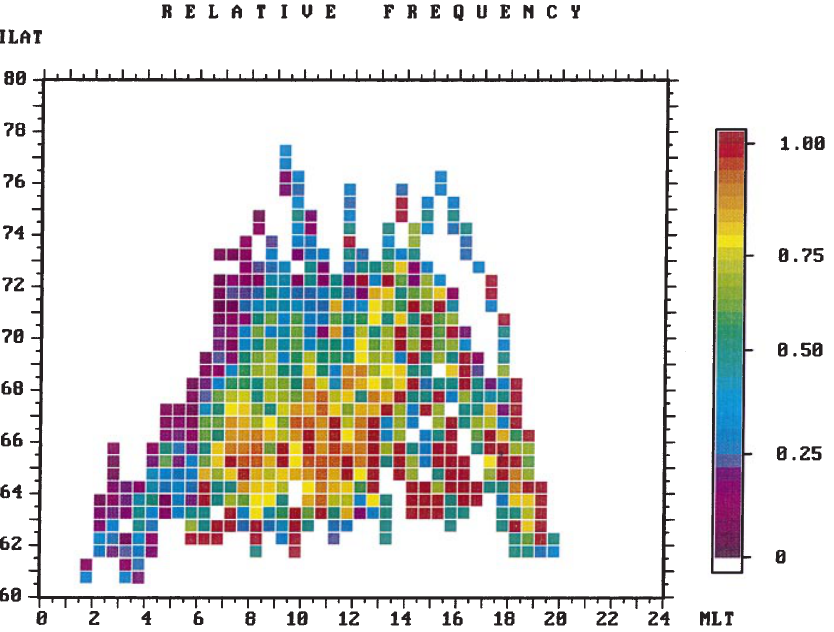
Fig. 4. Distribution of the gap crossings as a function of magnetic local time (MLT) and invariant latitude (ILAT). Data have been normalized taking into account the number of satellite passes in each bin. The total number of passes is 168 (see